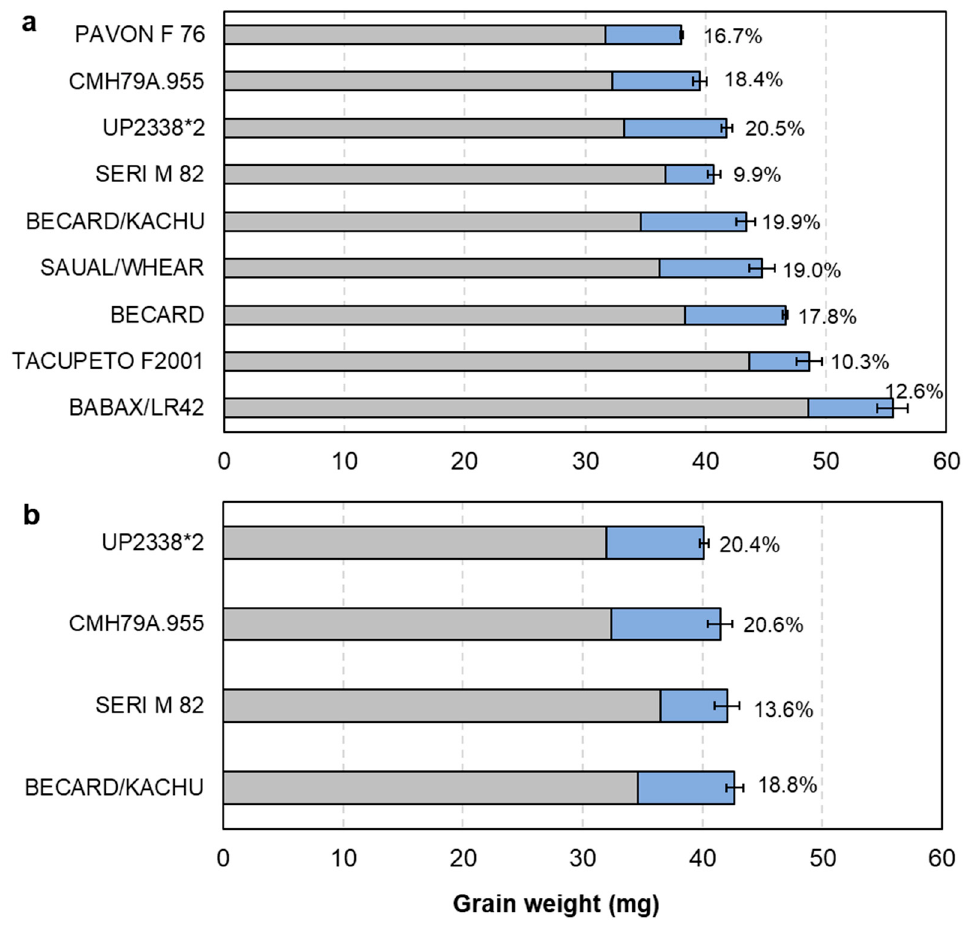
Figure 4. Grain weight in defoliated shoots (DEF, grey bars) and difference between CTRL and DEF (blue bars) in ( a ) subset 1 (9 cultivars) in 2013 ( p < 0.01 for cultivar and p < 0.001 for defoliation treatment) and ( b ) subset 2 (4 cultivars) combined data from 2013 and 2014 ( p < 0.01 for cultivar, p < 0.001 for defoliation treatment and p = 0.086 for year, all interactions were non-significant). Cultivars are sorted ascendingly by grain weight in CTRL. Percentages indicate the grain weight decrease in DEF relative to CTRL ( p < 0.001 for ( a ) and p < 0.05 for ( b )). Error bars correspond to S.E. for the difference between grain weight in CTRL and DEF.